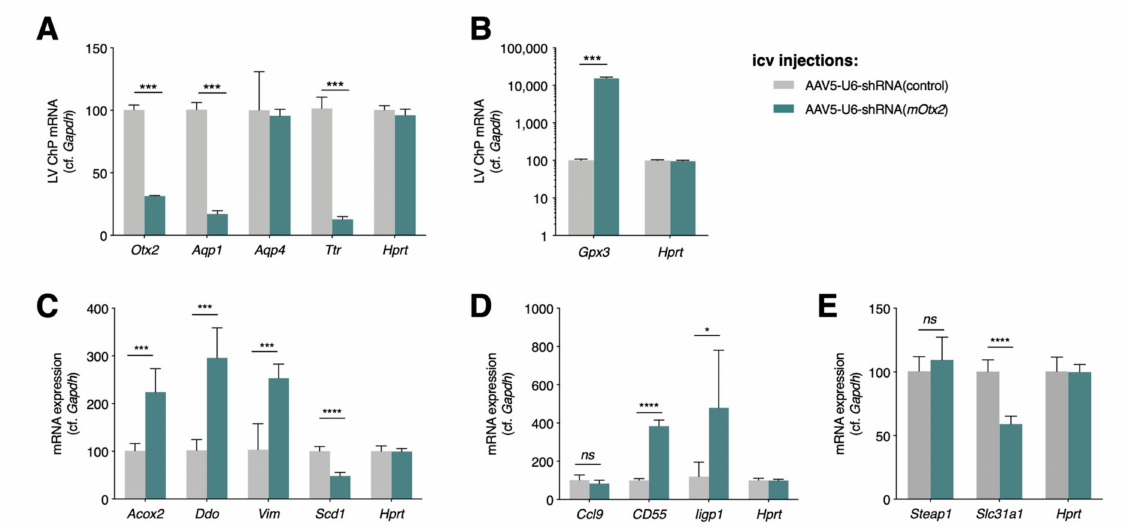
Figure 3. OTX2 regulates choroid plexus expression of oxidative stress, immune system, and metal transport genes. Quantitative PCR analysis of lateral ventricle (LV) ChP gene expression in wildtype mice after viral expression of shRNA against mouse (mRNA) Otx2 (shRNA- mOtx2 ) compared to control shRNA. ( A ) Analysis of control genes to validate shRNA- Otx2 activity; ( B ) Otx2 knockdown induces high expression of Gpx3 ; ( C ) Analysis of select genes involved in oxidative stress response; ( D ) Analysis of select genes involved in immune system response; ( E ) Analysis of select genes involved in metal ion transport (all values: mean ± SEM; n = 5; t -test; * p < 0.05, *** p < 0.001, **** p <